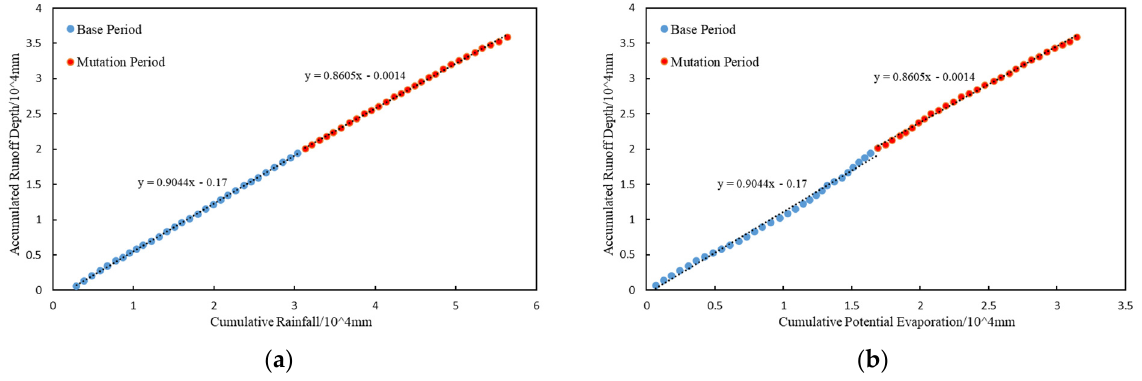
Figure 6. ( a ) Precipitation—runoff depth double accumulation curve in the Min River basin; ( b ) potential evapotranspiration—runoff depth double accumulation curve in the Min River basin.